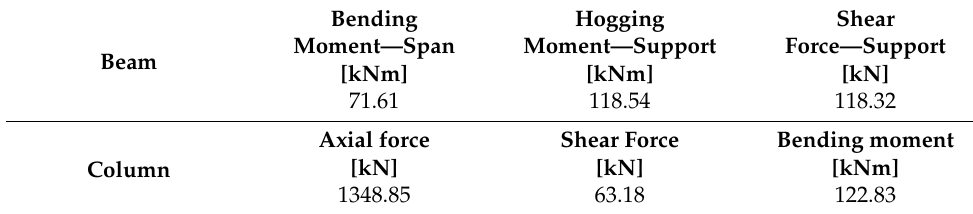
Table 10. Load effects for validation of RC frame (Section A).